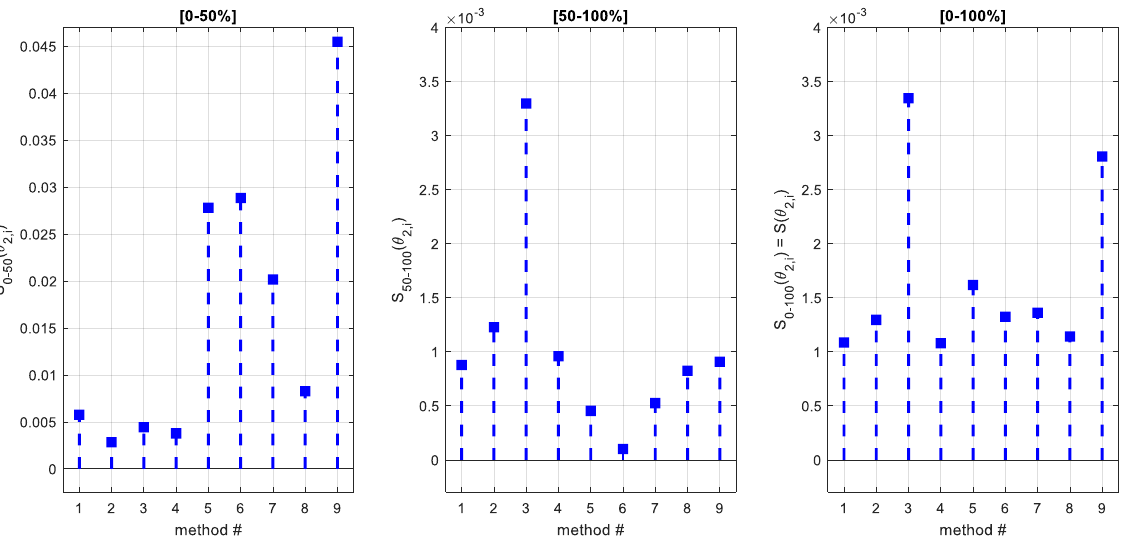
Figure 19. Graphical representation of data given in Table 19 for process P 2 . From left to right the performance indices S 0‒50 ( θ ̅ 2,i ), S 50‒100 ( θ ̅ 2,i ), and S( θ ̅ 2,i ), i = 1, …, 9, are shown, respectively, for each of the considered methods.